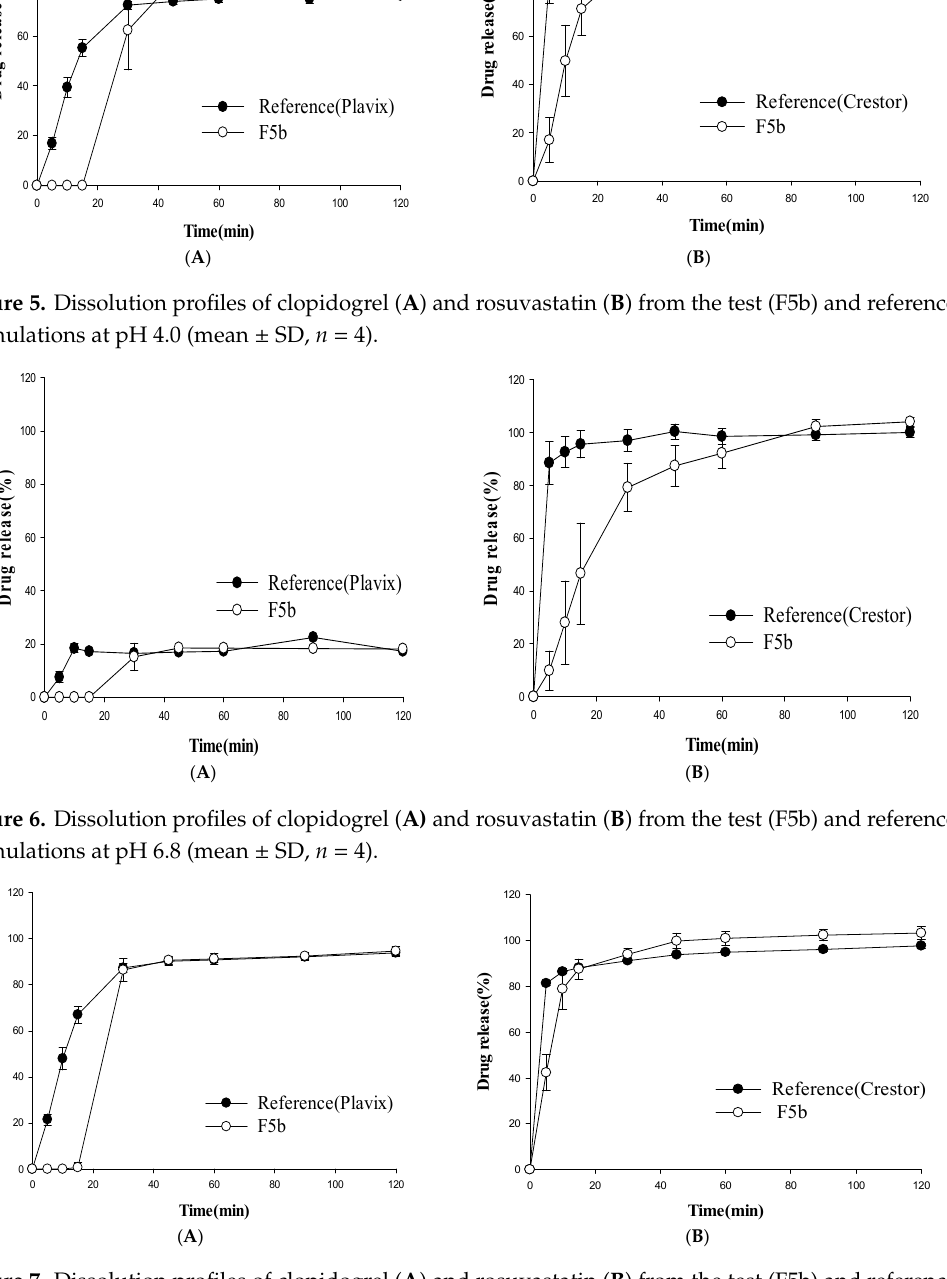
Figure 7. Dissolution profiles of clopidogrel ( A ) and rosuvastatin ( B ) from the test (F5b) and reference formulations in water (mean ± SD, n = 4).